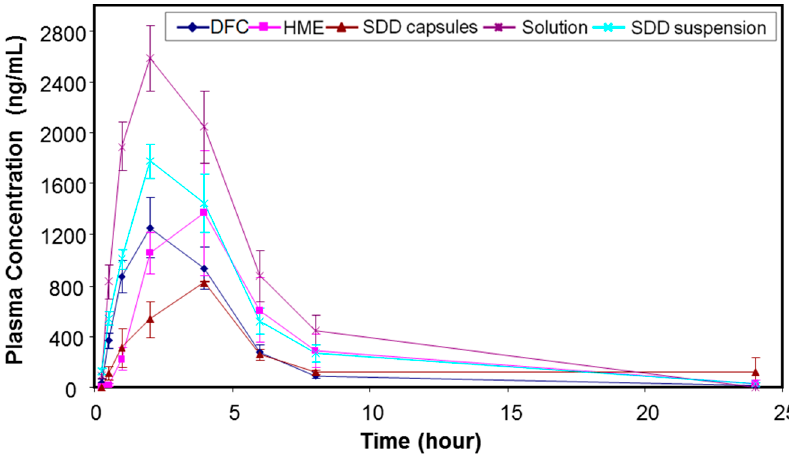
Figure 5. Profiles of mean (±SE) plasma concentration versus time after administration of MK-A formulations (15 mpk) to pentagastrin-pretreated male Beagle dogs ( n = 3 or 6).